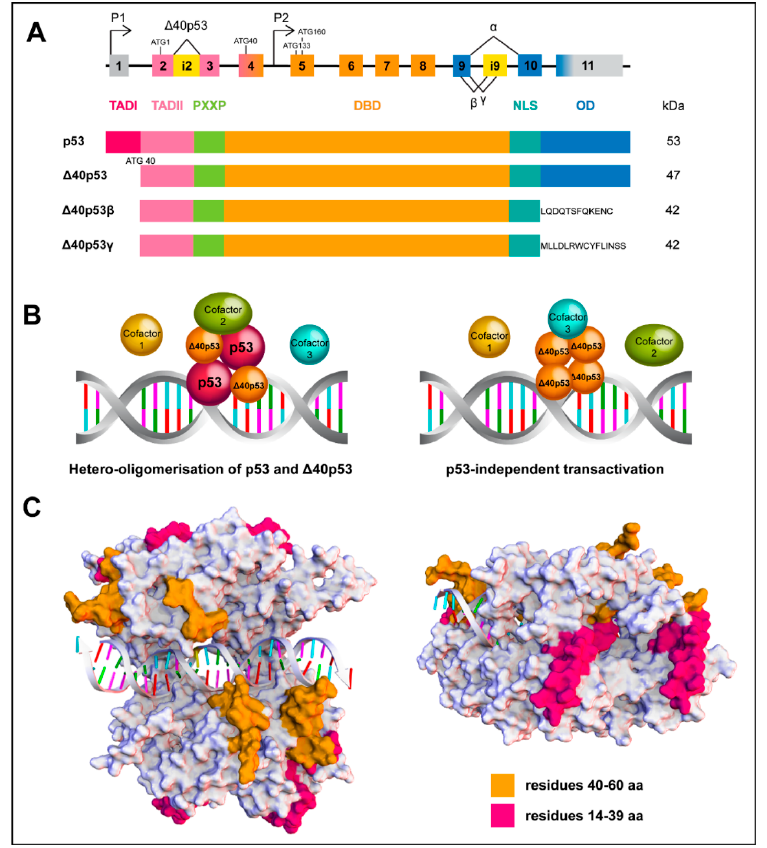
Figure 2 . Structure and assembly of wtp53 and the Δ 40p53 isoform. ( A ) Scheme of the p53 gene Figure 2. Structure and assembly of wtp53 and the ∆ 40p53 isoform. ( A ) Scheme of the p53 gene structure; structure; alternative splicing (^) and promoters (P1 and P2) are indicated. Δ 40p53 isoform is encoded alternative splicing (ˆ) and promoters (P1 and P2) are indicated. ∆ 40p53 isoform is encoded from P1 due to alternative splicing of intron 2 (i2) or alternative initiation of translation. Partial retention of intron 9 (i9) generates the β and γ isoforms (upper image) Functional domains of FLp53 and ∆ 40p53 isoforms (lower image). ( B ) Schematic overview of wtp53 and ∆ 40p53 interactions mediating transactivation.